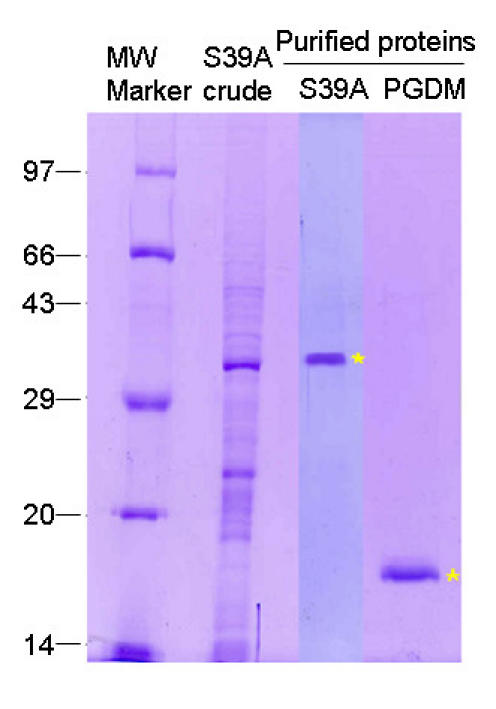
The crude lysate and purified proteins. About 5–10 μg of proteins were loaded on a 10% SDS-PAGE as indicated. The inactive PGDM and mutant yeast enolase 1 S39A and H159A has been indicated. The gel was stained with Coomassie blue.